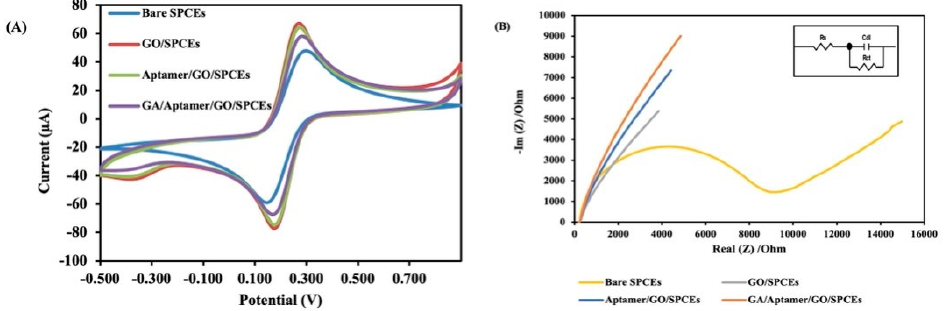
Figure 2. ( A ) Cyclic voltammograms of Bare SPCEs, GO–SPCEs showing successful immobilization of each layer. ( B ) EIS spectra of Bare SPCEs, GO-SPCEs, aptamer/GO–SPCEs, and GA/aptamer/GO–SPCEs in 5 mM [Fe (CN) 6 ] 4–/3– . The inserted circuit graph in ( B ) is the EIS fitting model. FTIR characterization was carried out for the characterization of the functionalized GO.